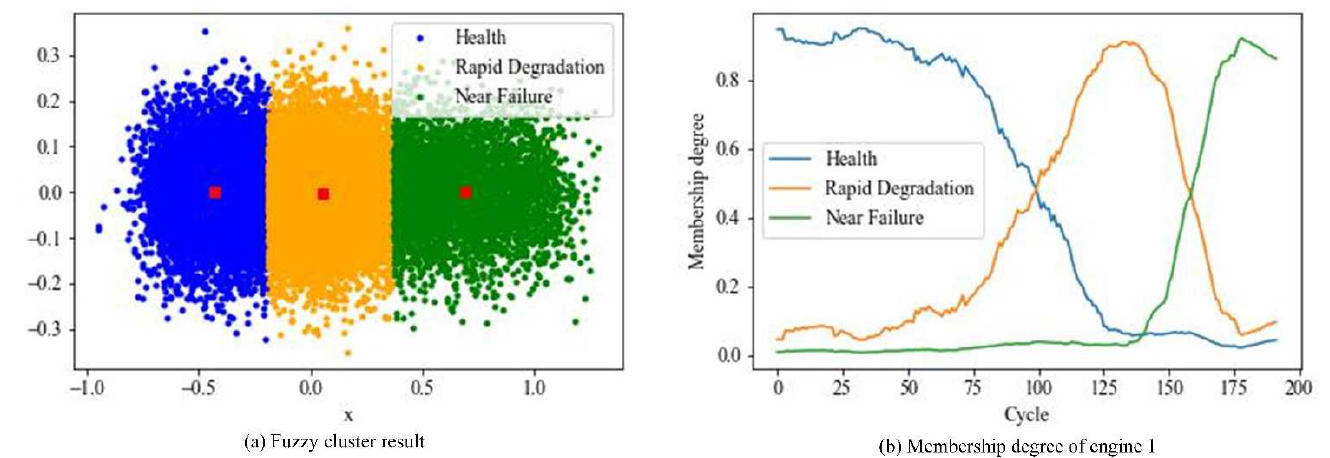
Figure 9. Fuzzy cluster result and membership degree curve.